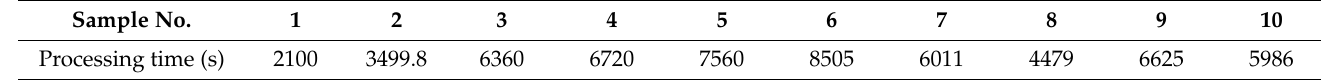
Table 3. First tool failure time.